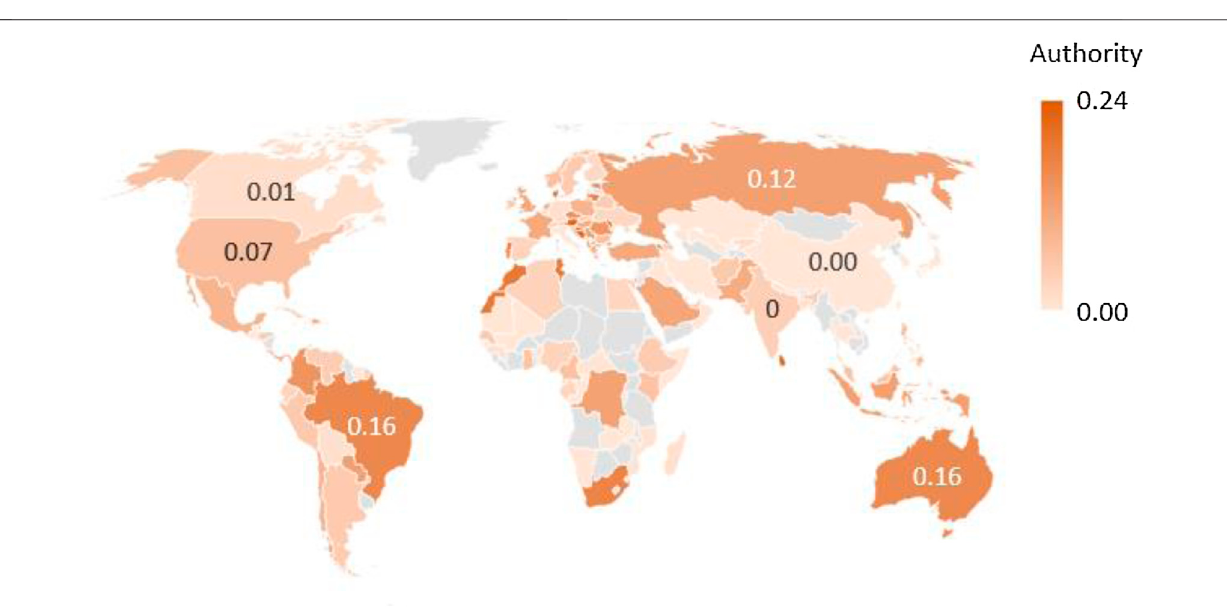
FIGURE 9 | The authority of the global COVID-19 pandemic